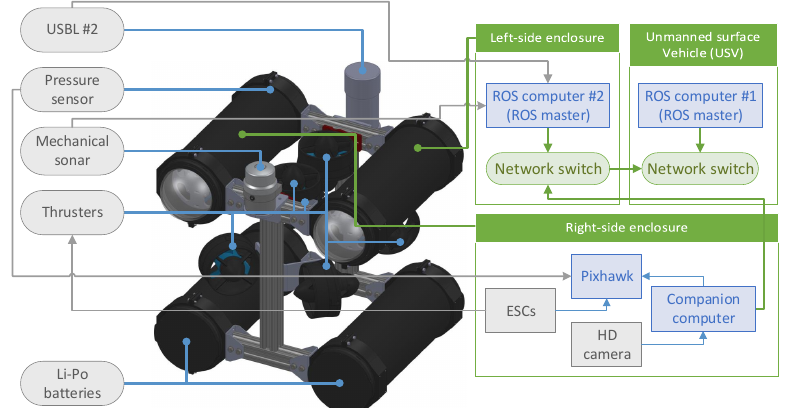
Figure 11. SystemoverviewoftheAUV:High-level(RobotOperatingSystem(ROS)computers),intermediate- level (companion computer and Pixhawk flight controller), and low-level control (thrusters, ultra-short baseline (USBL), pressure sensor, and mechanical imaging